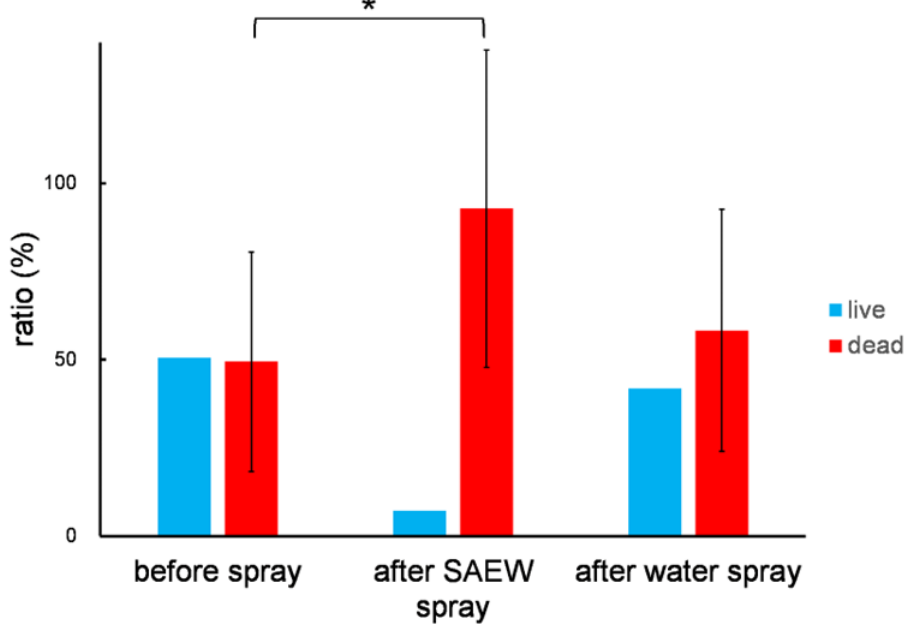
Figure 4. Microorganism disinfection activity of SAEW in the greenhouse. The data was an average of six replicates with standard deviation. An asterisk indicates a statistically significant difference (p<0.01).